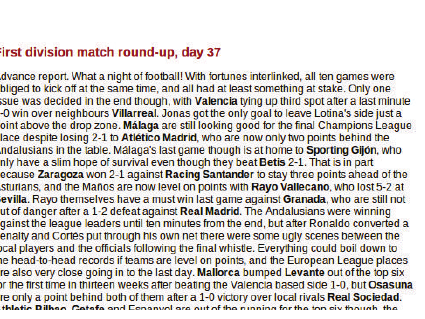
Figure 3: A text object with heading. Sometimes such objects may occur without a heading also.